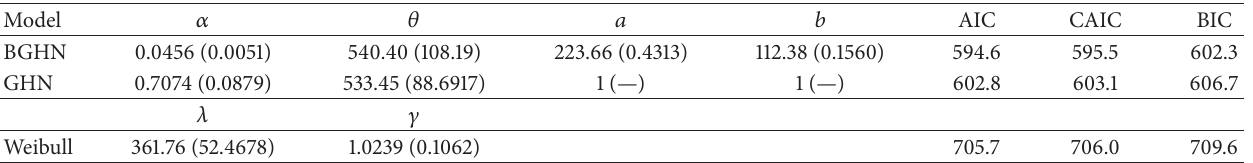
Table 3: MLEs of the model parameters for the radiotherapy data, the corresponding SEs (given in parentheses), and the AIC, CAIC, and BIC statistics.